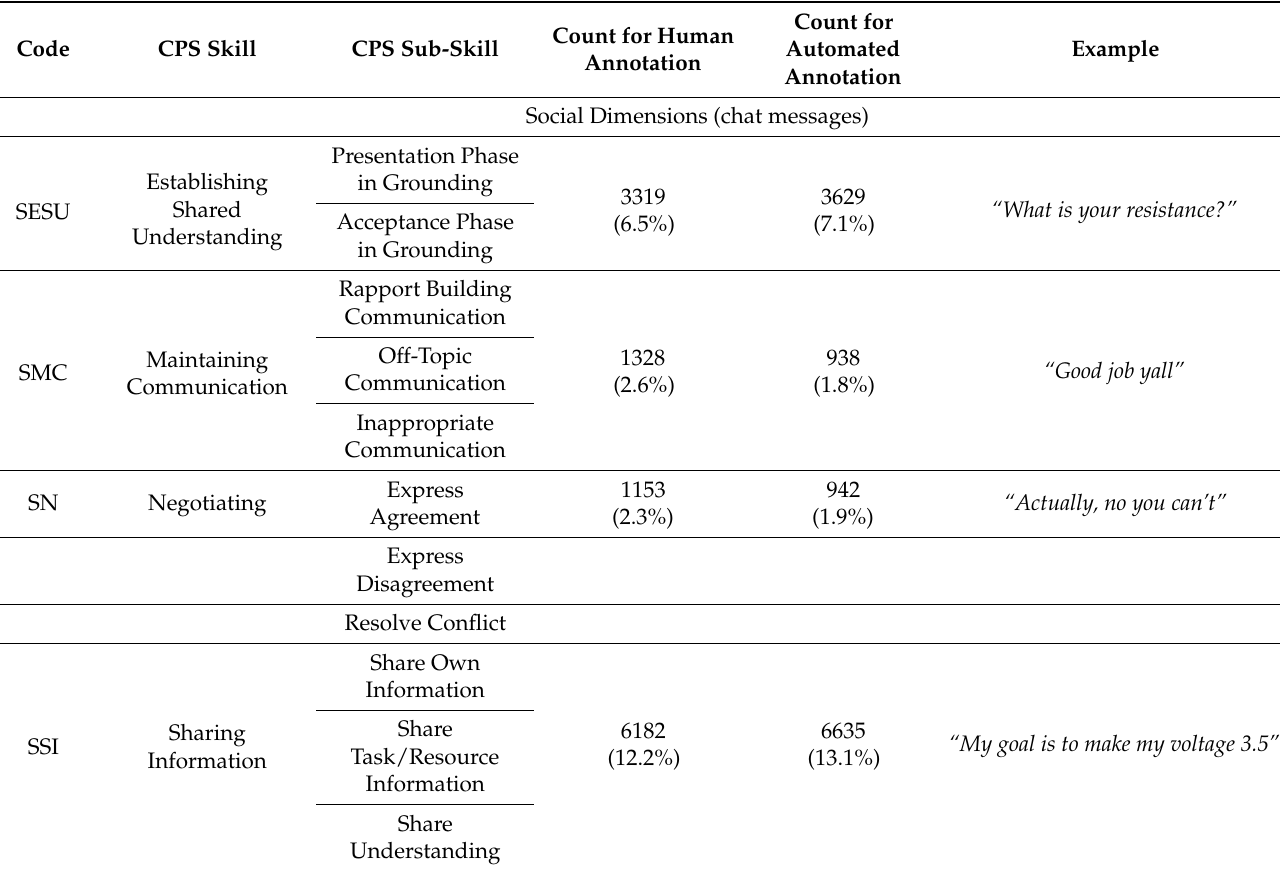
Table 2. Counts and proportions of CPS skills identified across annotation methods with